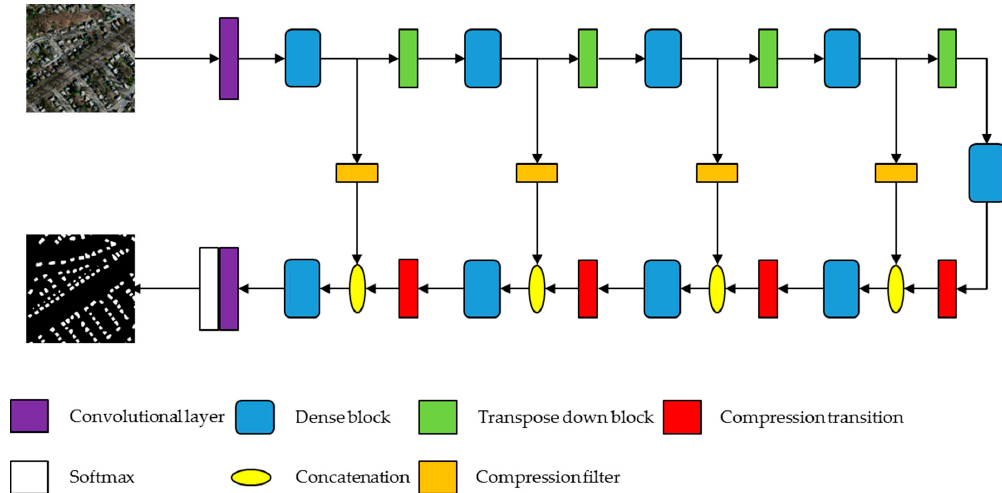
Figure 1. An illustration of the architecture of the multiple-feature reuse network (MFRN). The MFRN is composed of an encoder and a decoder. An RGB image patch is input to the model. The purple blocks are convolutional layers. The white block following the final convolutional layer represents a softmax classifier. The blue blocks are dense blocks composed of a stack of densely connected convolutional layers. The green blocks represent a transpose-down block composed of pooling layers. The orange blocks represent the compression filters in the skip connections. The red blocks represent compression transitions composed of a transposed convolutional layer.